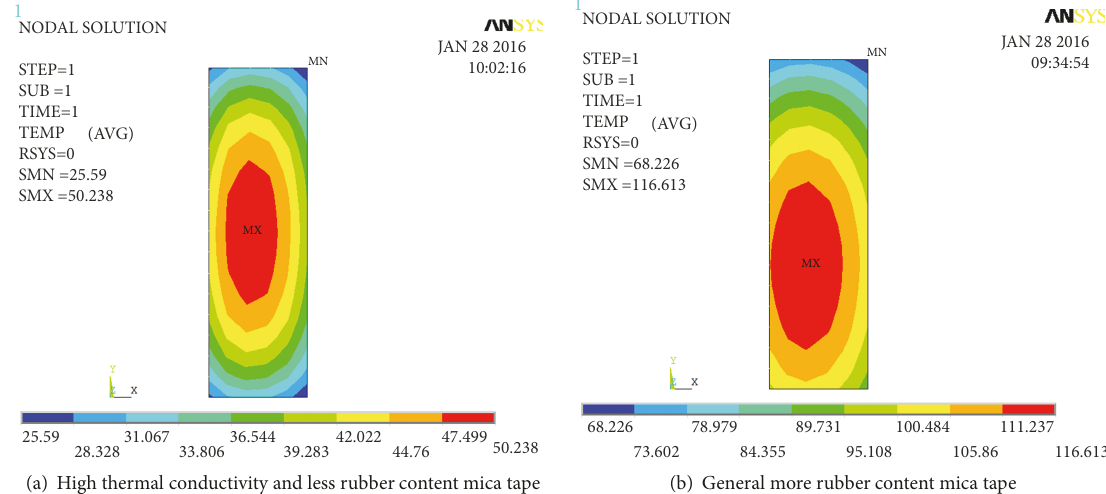
Figure 11: The comparison of coil temperature field